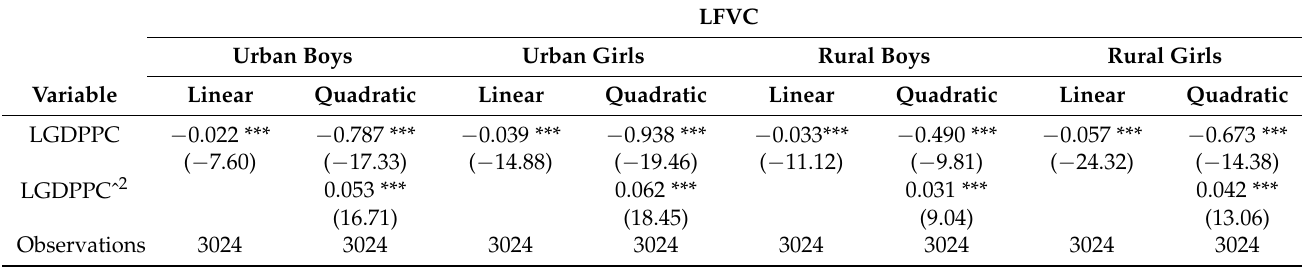
Table A2. The results for IV